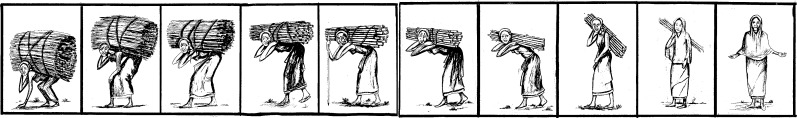
Example of culturally adjusted rating scale.